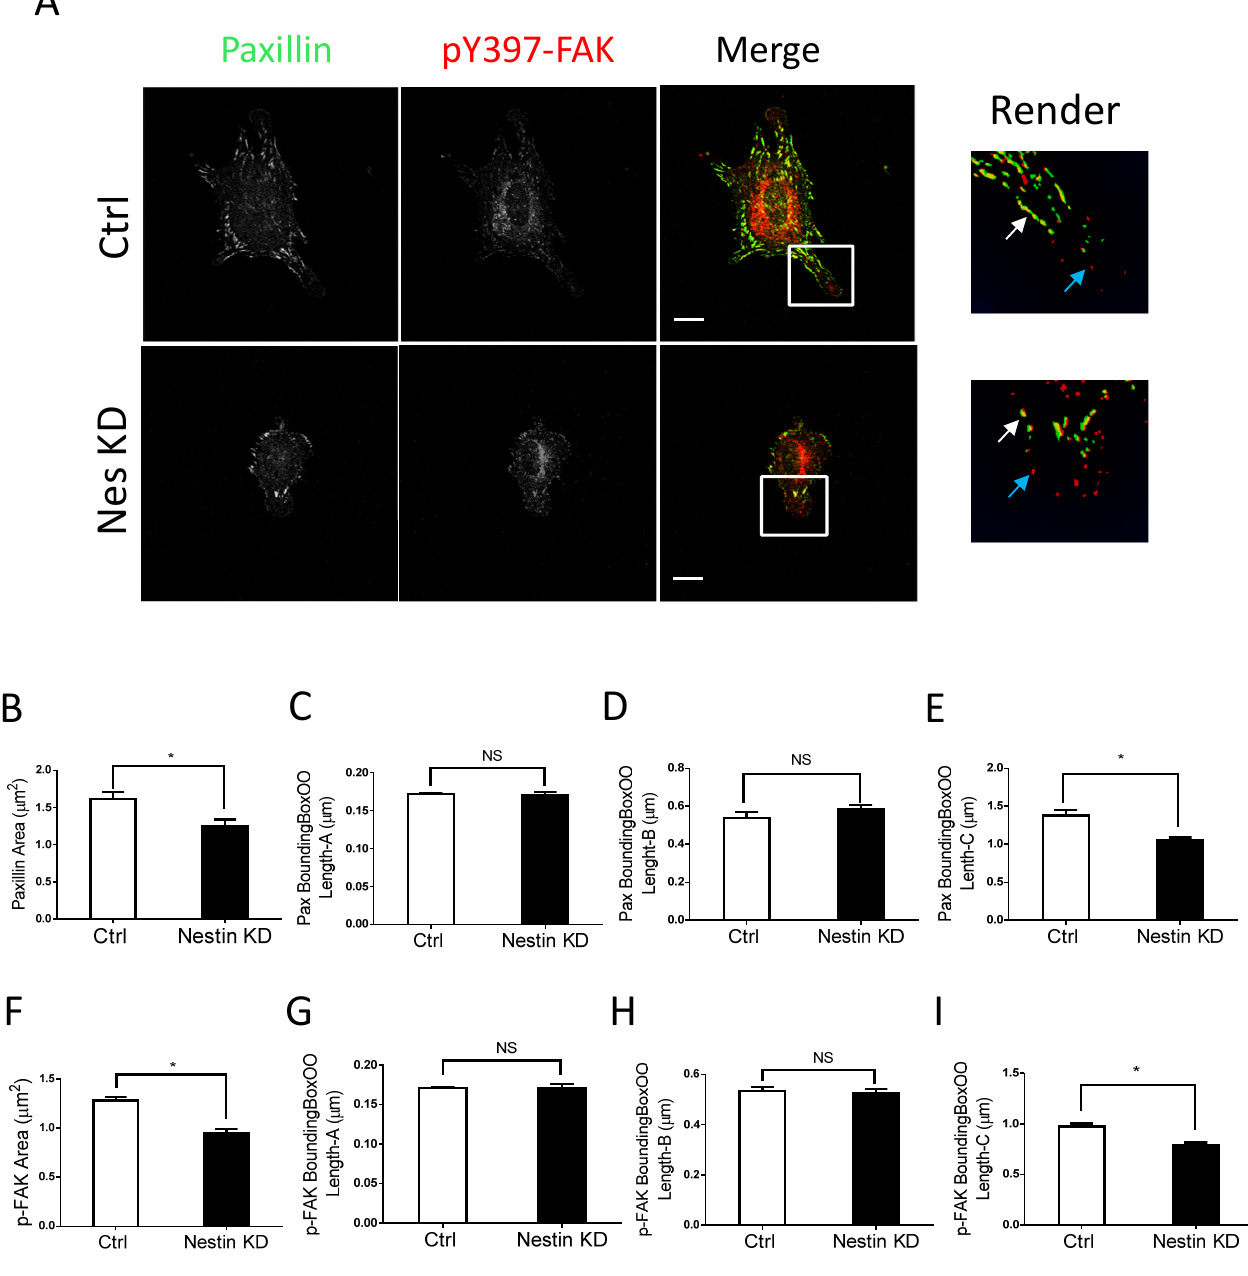
Figure 2. Nestin KD reduces size of focal adhesions. ( A ) Ctrl and nestin KD human ASM cells were plated on collagen-coated coverslips for 45 min and immunostained for paxillin and pY397-FAK. Cell images were captured using a confocal microscope and the Imaris software was used to render and analyze images. Scale bar, 15 µ m. The white arrows point spots colocalized with paxillin and pY397- FAK. The cyan arrows point to pY397-FAK labeling spots. ( B – I ) The area, BoundingBoxOO Length- A/B/C of paxillin and pY397-FAK staining were calculated using the Imaris software. BoundingBox OO length-A measures the length of the shortest principal axis. BoundingBox OO length-B measures the length of the second longest principal axis. BoundingBox OO length-C measures the length of the longest principal axis inside of the object. Data are means ± SE ( n = 5, * p < 0.05). t -test was used for statistical analysis. NS, not